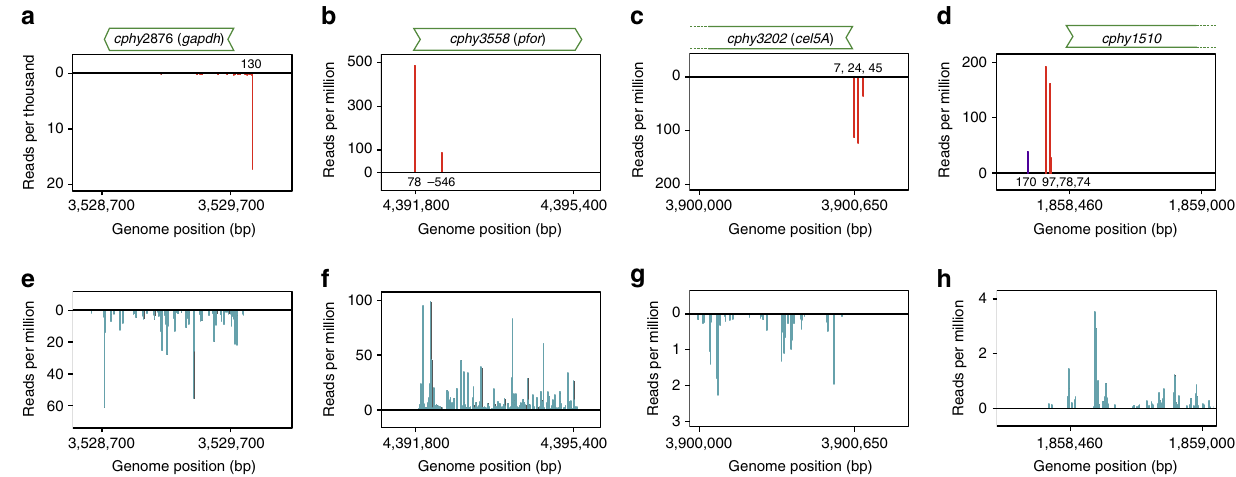
Figure 3 | Capp-Switch reads start at specific genome positions corresponding to putative TSS. The number of reads starting at each genome position are shown for Capp-Switch ( a – d ) and RNA-seq ( e – h ). The cphy2876 gapdh gene ( a , e ) has a single TSS (glucose data shown). The cphy3558 pfor gene ( b , f ) has an upstream TSS and an intragenic sense TSS (glucose data shown). The cphy3202 cel5A cellulase gene ( c , g ) has three TSS during growth on cellulose. The cphy1510 xylanase gene ( d , h ) is expressed from three TSS on xylan (red bars) and a single, upstream TSS on pectin (purple). Plots show the number of reads starting at each genome position with forward strand reads on the positive Y axis and reverse strand reads on the negative Y axis. Distance to the start codon is shown at the base of TSS